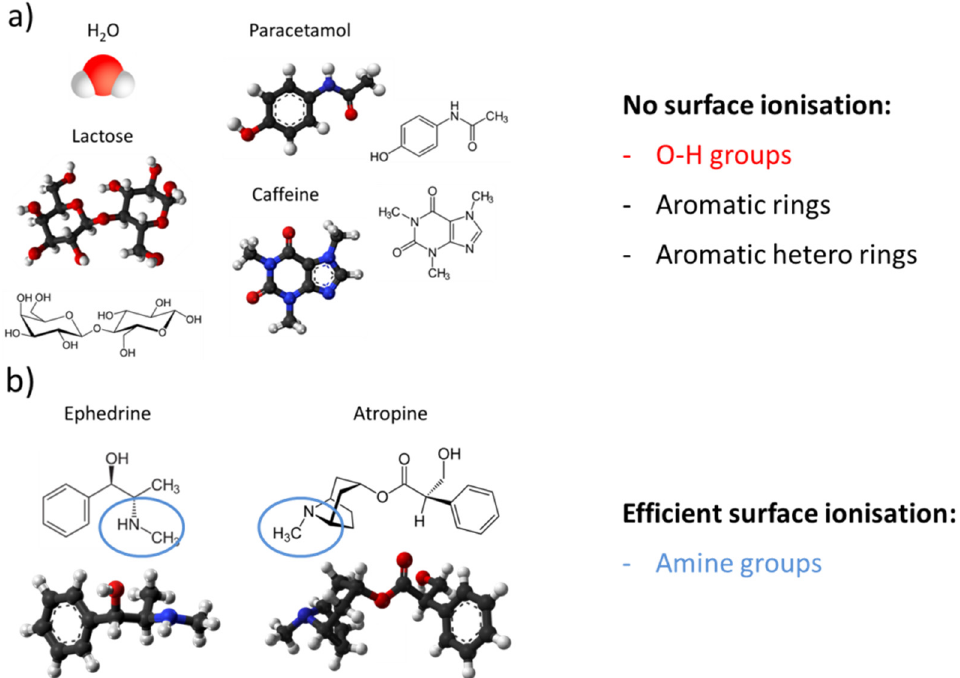
Figure 18. Molecular structures of the substances used in the evaporation tests reported in Figure 17. Color coding of atoms: carbon (black); hydrogen (grey); oxygen (red); nitrogen (blue): ( a ) substances not detectable by surface ionization, ( b ) substances well ‐ detectable by surface ionization.